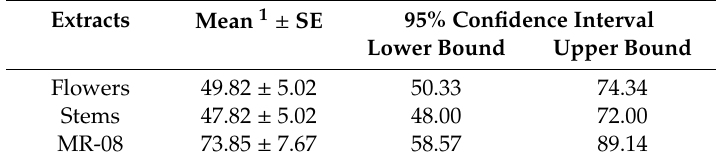
Table 2. Adjusted estimated marginal (EM) means of the repellence of Lavandin flowers and stems aromatic waters and of the synthetic repellent MR-08 against Tribolium confusum adults.